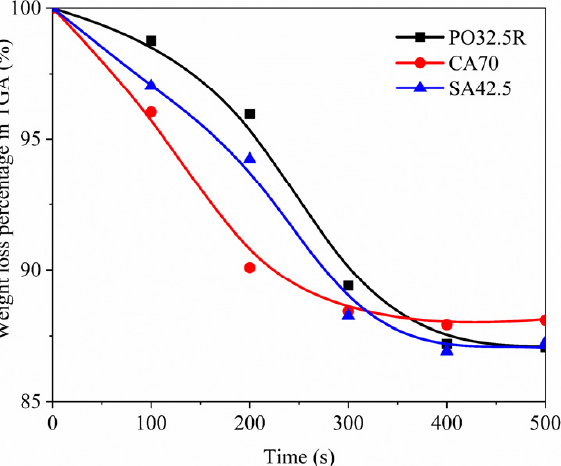
Figure 7. Percentages of weight loss of PO32.5R, CA70, and SA42.5 cement-bonded oxygen carriers in the TGA tests with 15% CO and 20% CO 2 balanced by N 2 at 950 °C.